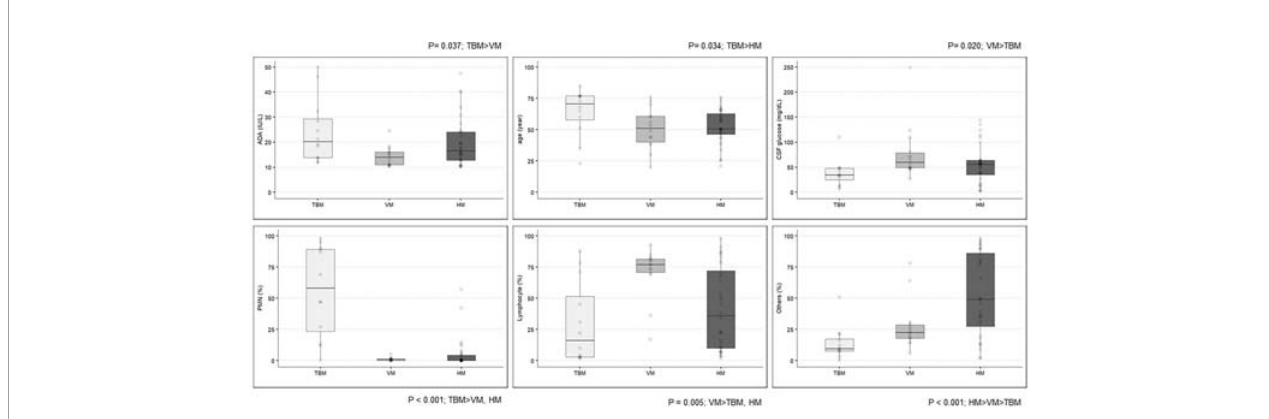
FIGURE 2 | Clinical and laboratory characteristics among the de fi nite TBM, VM, and HM groups. ADA, adenosine deaminase; TBM, tuberculous meningitis; VM, viral meningitis; HM, hematologic malignancy; CSF, cerebrospinal fl uid; PMN, polymorphonuclear neutrophils.